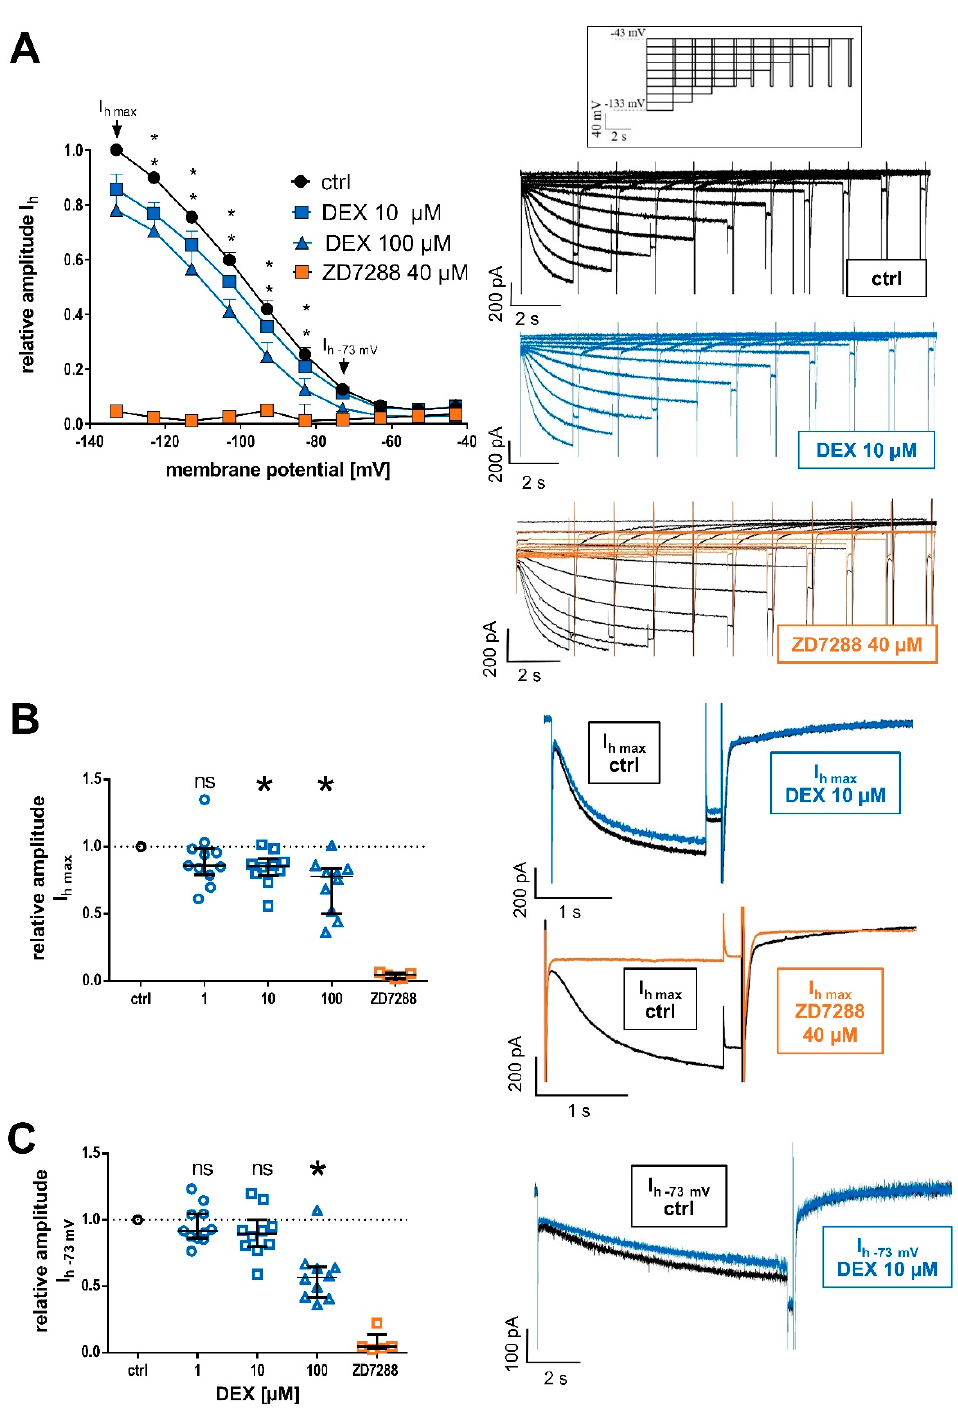
Figure 2. ( A ) Relative changes of HCN-mediated I h current amplitudes at respective membrane po- tentials after DEX application (10 µM and 100 µM) compared to the control and the effect of the selective HCN channel blocker ZD7288 (40 µM). Beginning at − 83 mV, 10 µM DEX induced a sig- nificant reduction in I h . On the right, representative current traces from a TC relay neuron under control conditions and after the application of 10 µM DEX for 45 min. In comparison, 40 µM of ZD7288 resulted in a near complete attenuation of I h currents over the complete voltage range. The voltage-clamp protocol is shown above and * p < 0.05. ( B ) Relative reduction in the maximal I h cur- rent amplitude (I h max ) was recorded when the cell was hyperpolarized to − 133 mV. The observed changes were significant beginning at a concentration of 10 µM DEX. On the right, representative current traces of I h max under control conditions and in the presence of 10 µM DEX. The reduction observed after adding 40 µM of ZD7288 (orange) was almost complete, as depicted below. ( C ) At